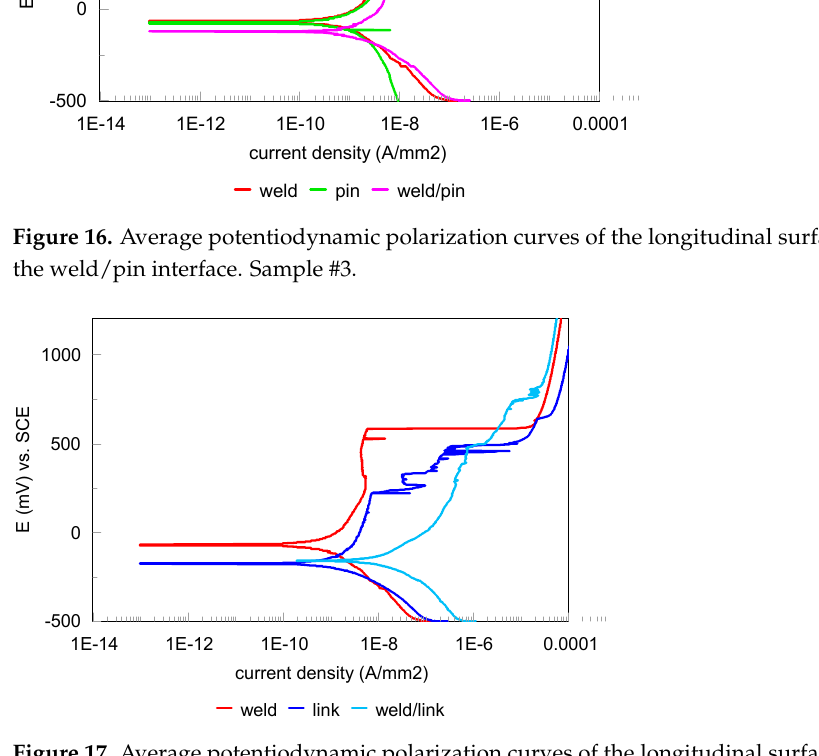
Figure 17. Average potentiodynamic polarization curves of the longitudinal surface (weld, link and weld/link interface). Sample #3.